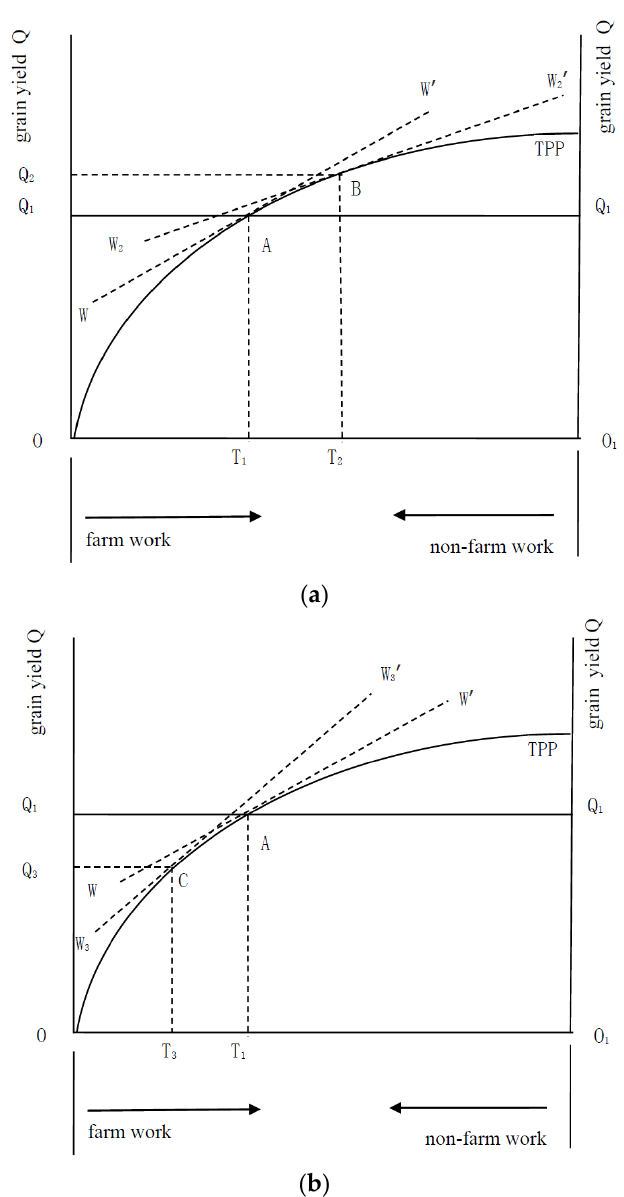
Figure 4. ( a ) Influence of off-farm employment opportunities on farmers’ abandonment behavior (lower wage). ( b ) Influence of off-farm employment opportunities on farmers’ abandonment behavior (higher wage).